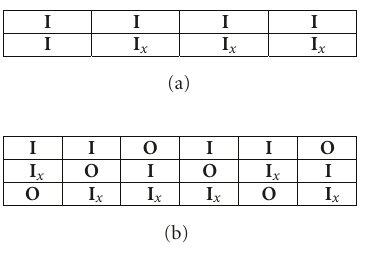
Figure 4: Structure of obtained quasi-cyclic LDPC codes.